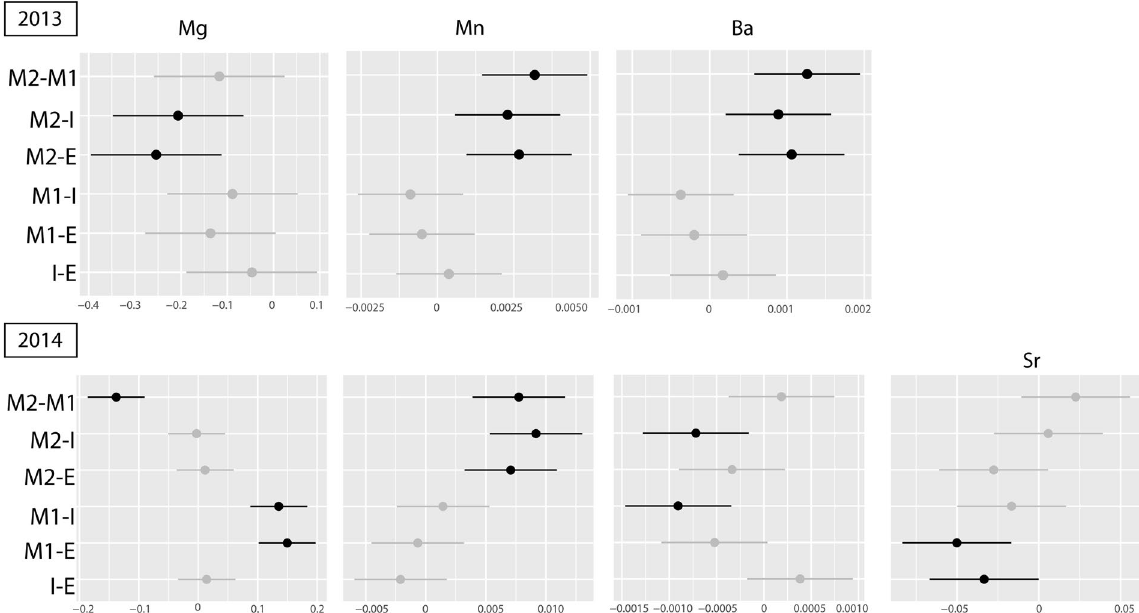
Figure 5. Tukey plot with black lines indicating significant differences in elemental ratios of trace elements fingerprints in cockle shells among areas within Ria de Aveiro (ANOVA, Tukey test comparisons, p < 0.05) over two consecutively years (2013 and